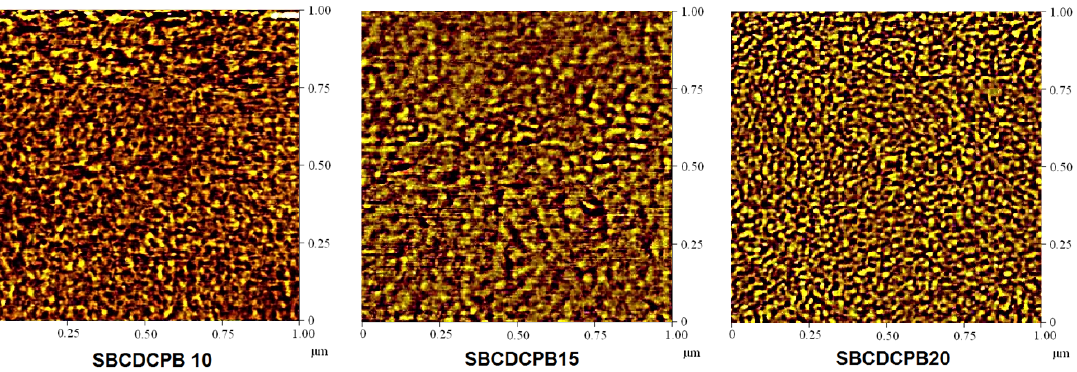
Figure 6. Atomic force microscopic (AFM) images of sulfonated membranes.